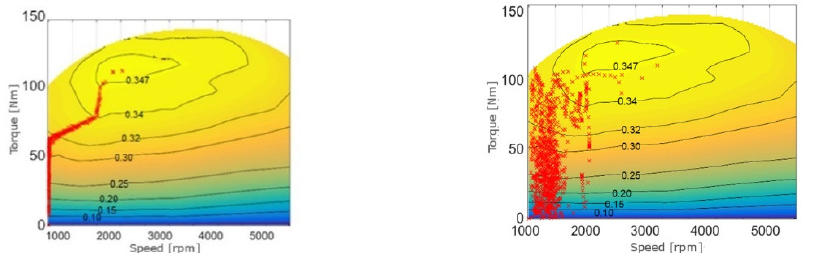
Figure 29. Series/parallel ( left ) and parallel architecture ( right ): ICE working points.